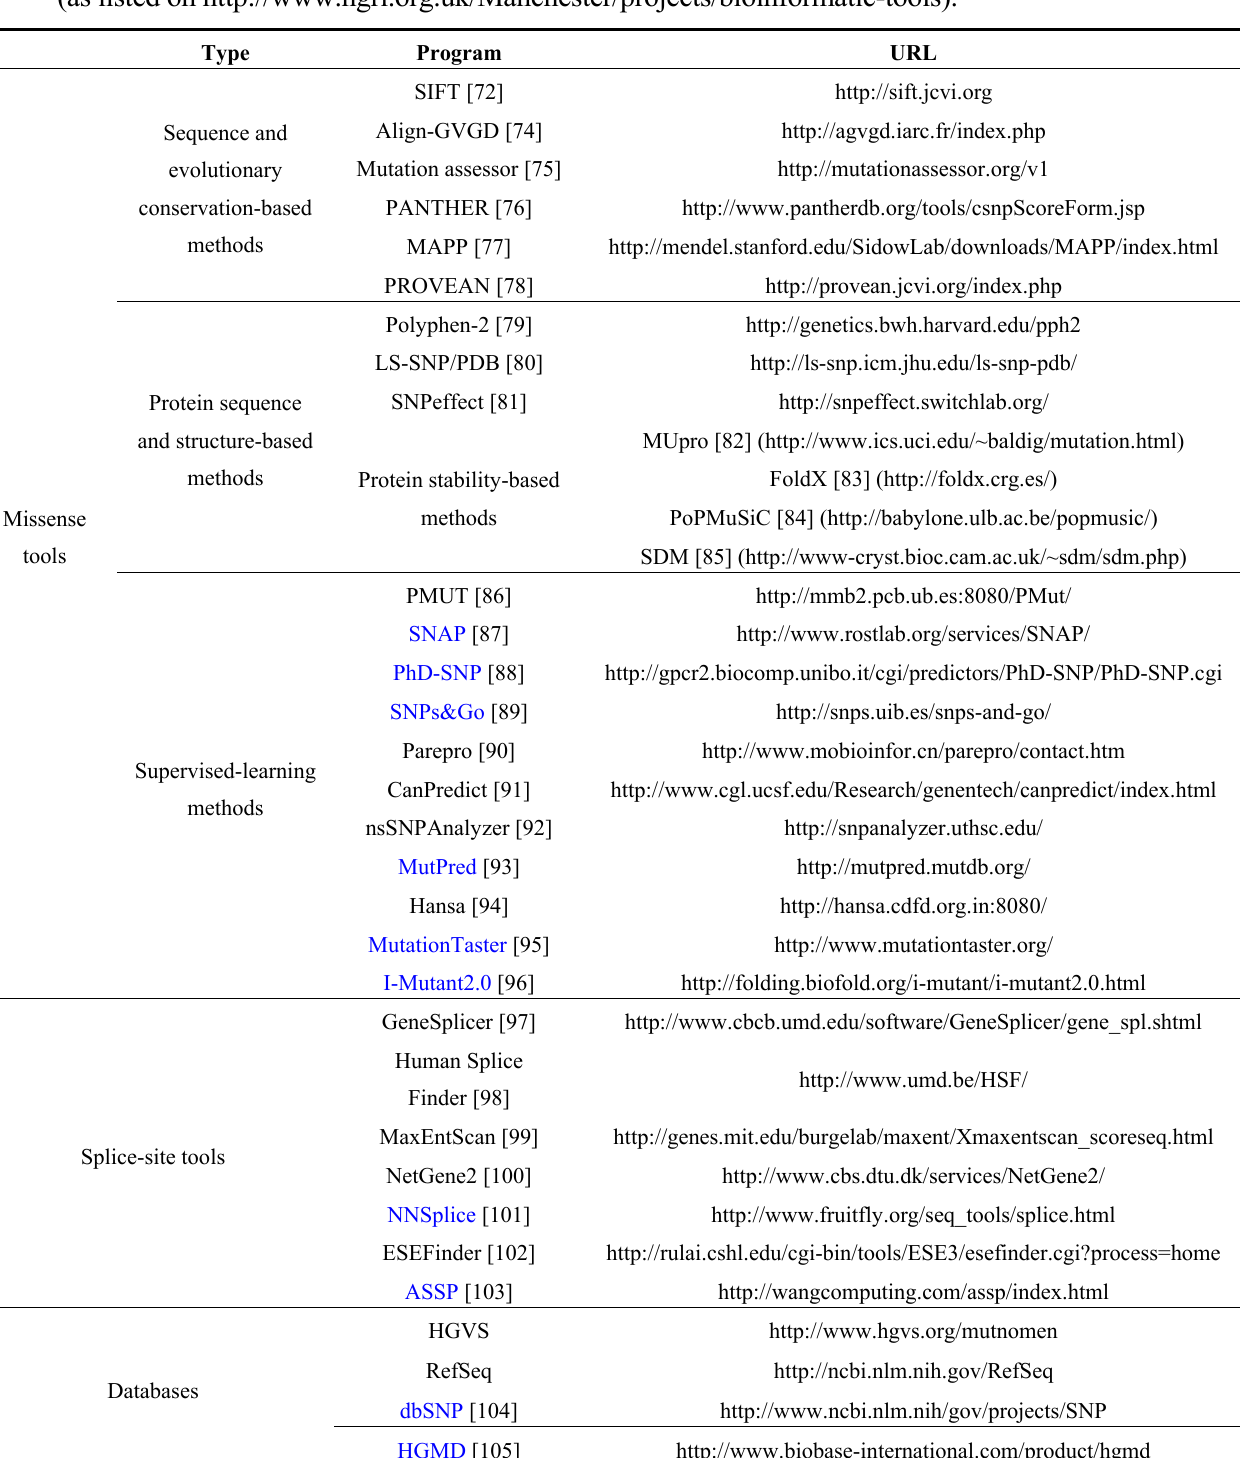
Table 4. Resources for predicting mutant protein function and variant interpretation (as listed on